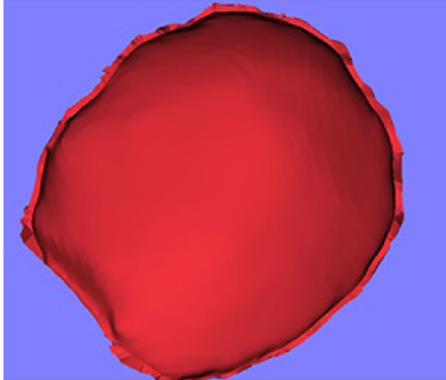
Figure 11. The generated initial implant.